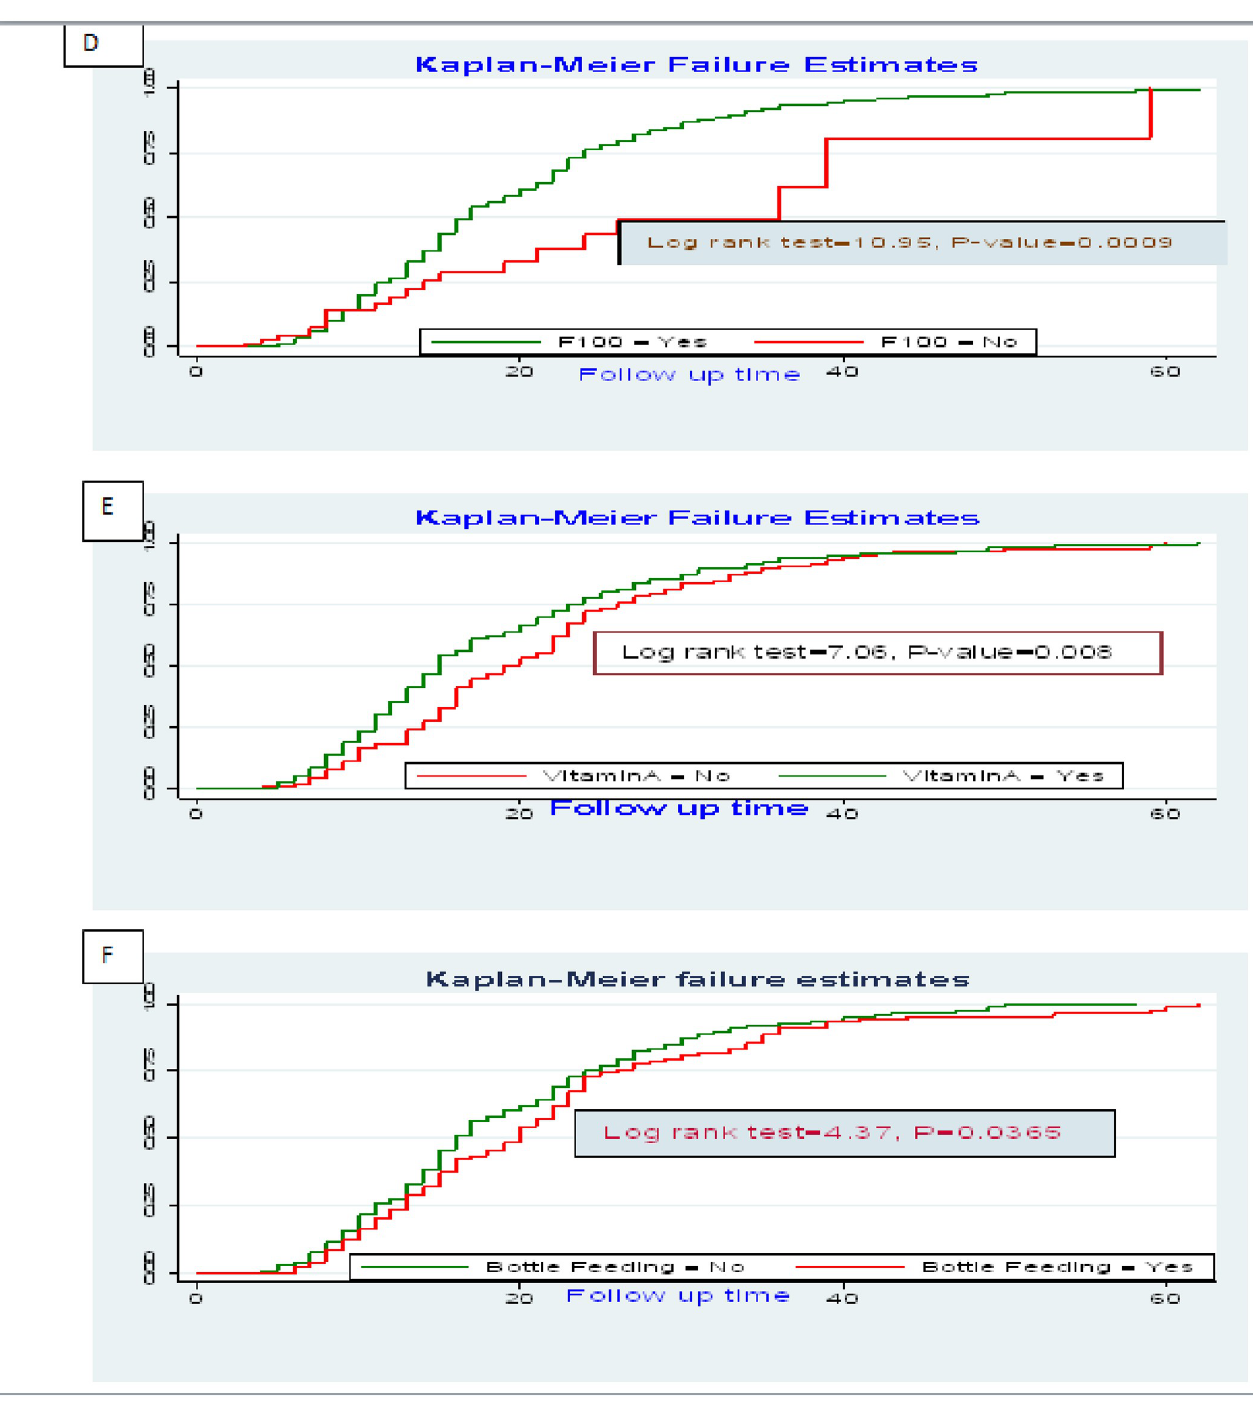
Fig 5. Log rank survival estimates for time to recovery among SAM children with independent predictors in SPHMMC, Addis Ababa, Ethiopia form 2012 to 2019 (D: Survival Estimate with F100; E: Survival Estimate with Vitamin A: F: Survival Estimate with bottle feeding).